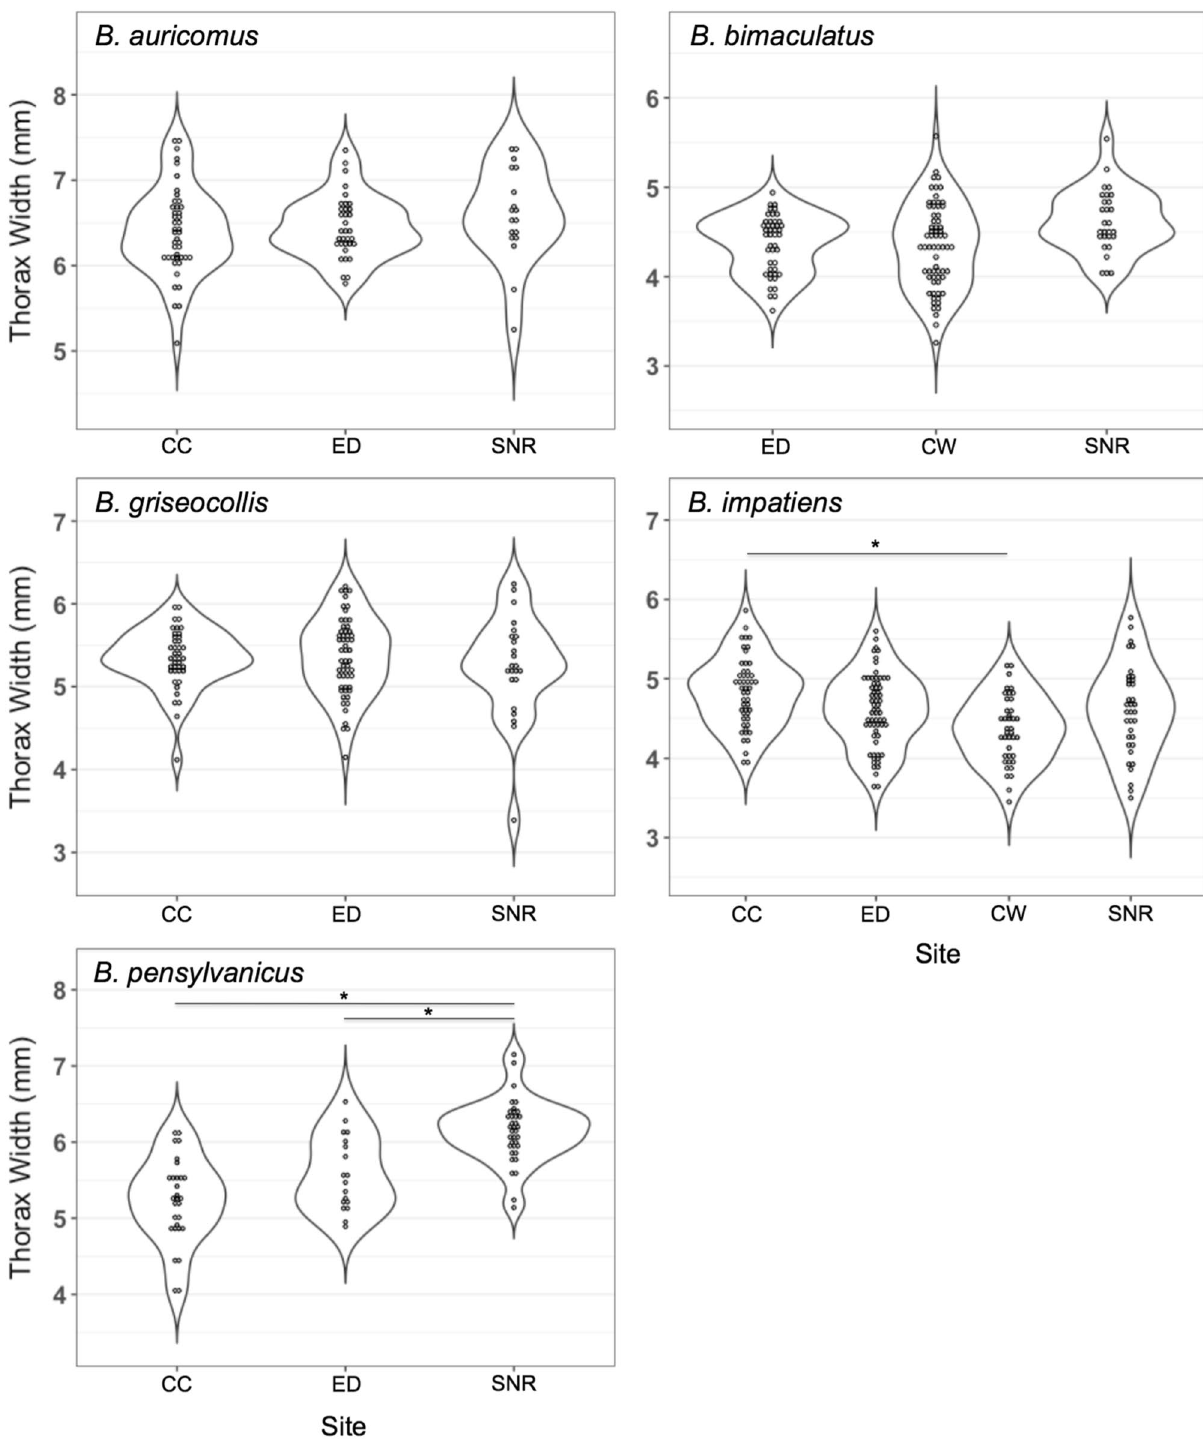
Figure 2. Thorax widths of worker bumble bees ( Bombus spp.) across the urban gradient in the greater Saint Louis region. Sites are arranged from left to right by increasing distance from Saint Louis City. Asterisks (*) indicate statistically significant differences between means of intraspecific subpopulations following Bonferroni correction (i.e., p < 0.00278). CC Calvary Cemetery, CW Castlewood State Park, ED EarthDance Farms, SNR Shaw Nature